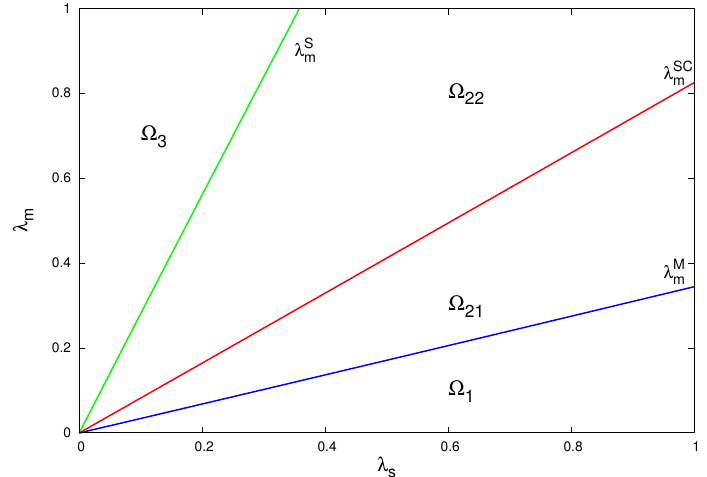
Figure 2. Effect of CEA information accuracies under in-house